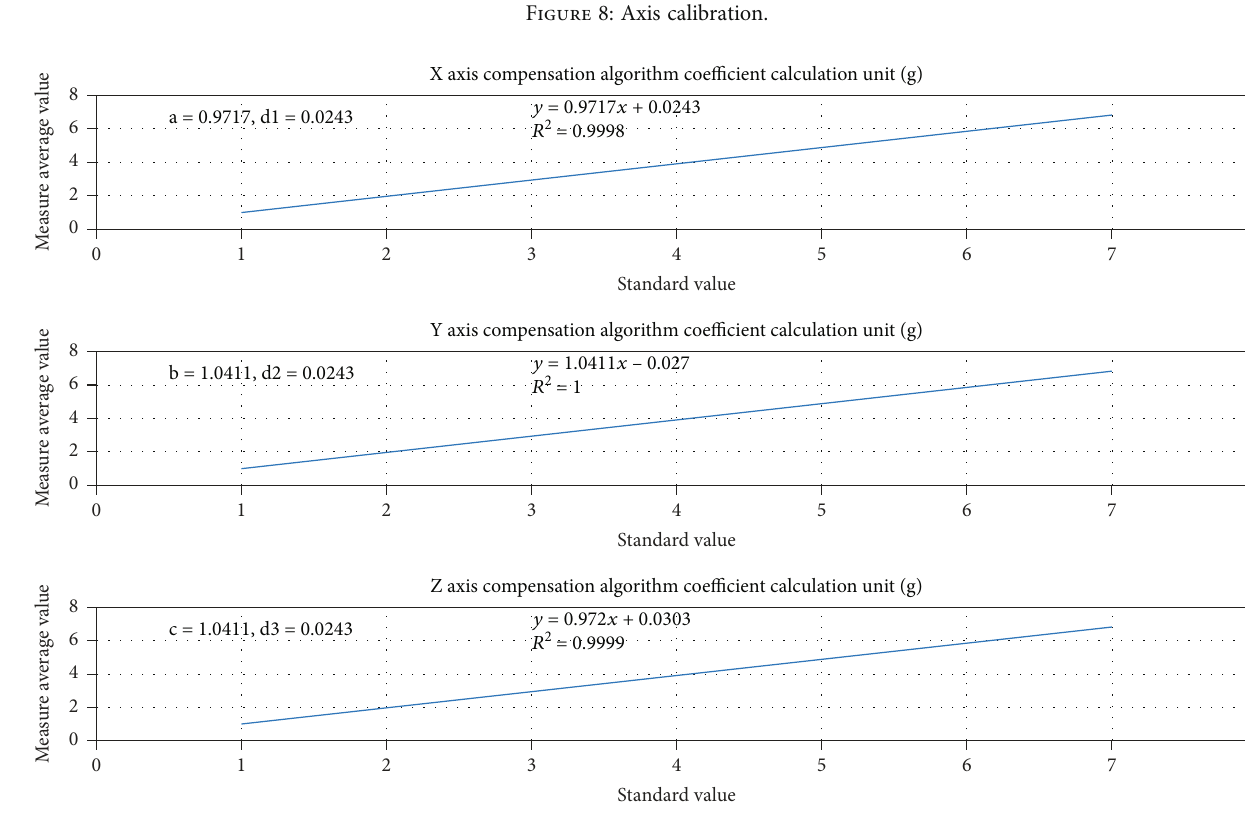
Figure 9: Compensation algorithm coe ffi cient calculation of the shock and vibration acceleration recorder (top: x -axis calibration equation, middle: y -axis calibration equation, and bottom: z -axis calibration